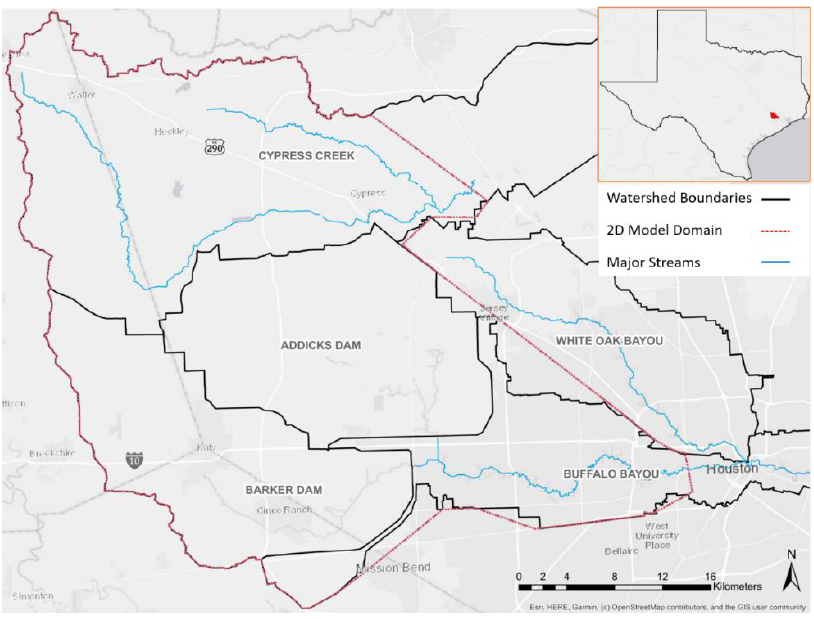
Figure 1. Overview of West Houston, TX watersheds.